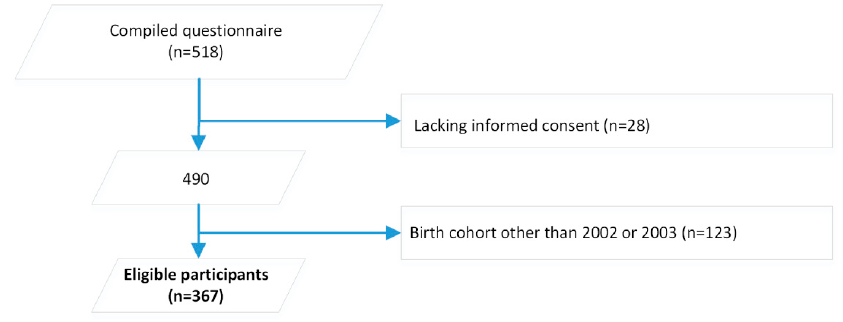
Figure 1. Number of participants after application of exclusion criteria ( n = 367).